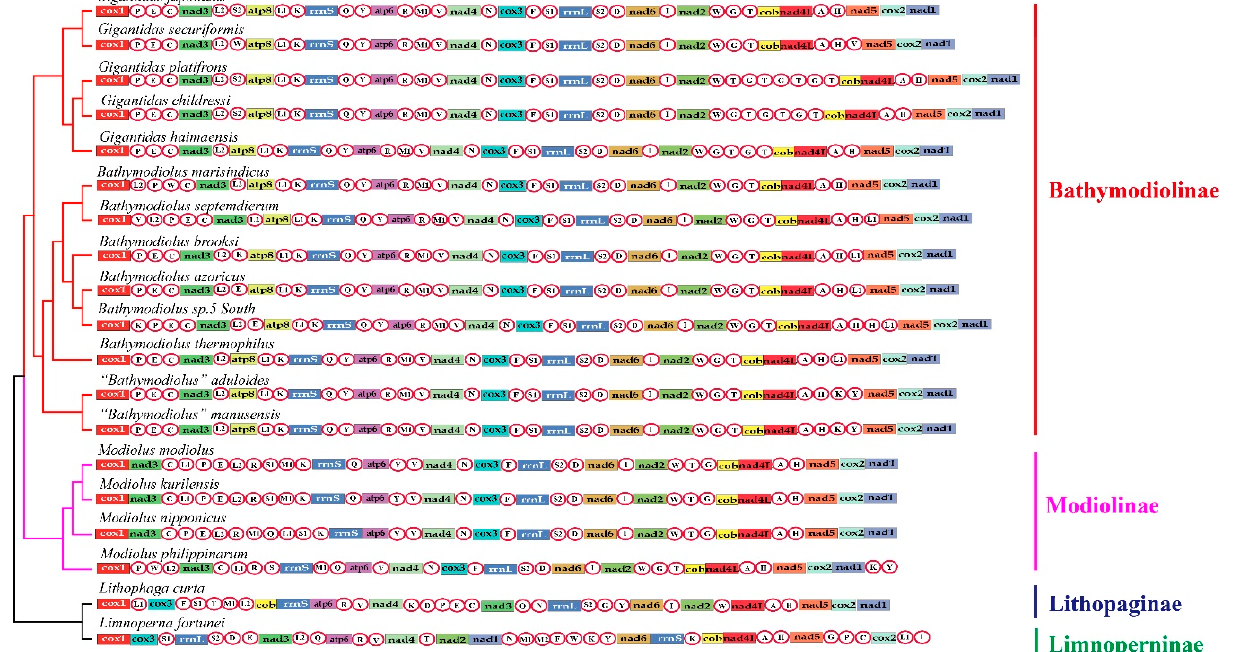
modioline mitogenomes possessed a gene order notably different from that of other mus-